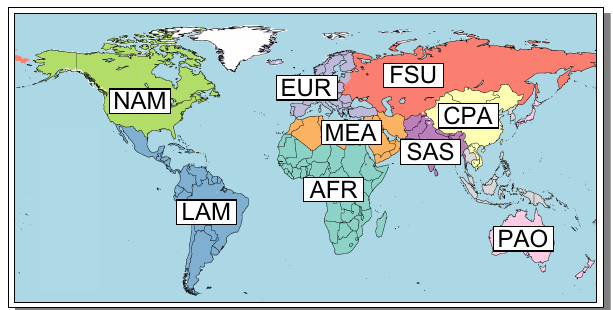
Fig. 1. The ten MAgPIE world regions. Sub-Sahara Africa (AFR), Centrally Planned Asia (CPA), Europe (including Turkey) (EUR), Former Soviet Union (FSU), Latin America (LAM), Middle East and North Africa (MEA), North America (NAM), Pacific OECD (Australia, Japan and New Zealand) (PAO), Pacific Asia (PAS), and South Asia